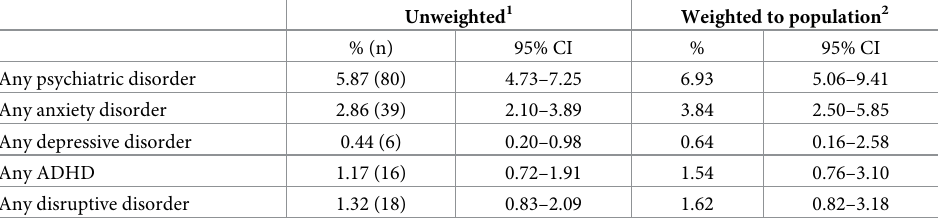
Table 2. Prevalence of main categories of DSM-IV disorders among 10-14-year-old participants in the Bergen Child